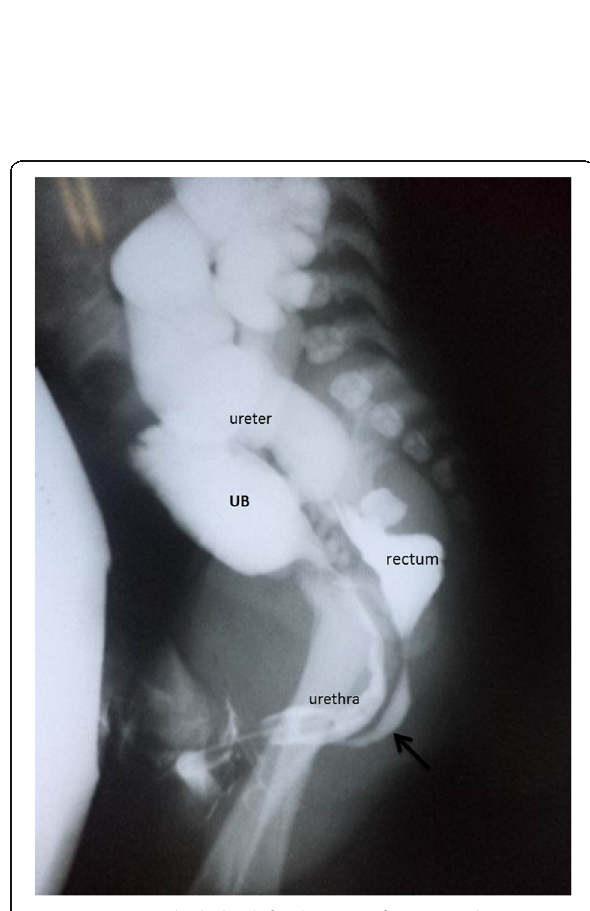
Fig. 13 Recto-urethral (distal) fistula in an infant. Ascending cysto- urethrogram (lateral view) showing the fistulous tract (arrow) between the rectum and the distal urethra. The image also shows vesico-ureteric reflux with markedly dilated and tortuous